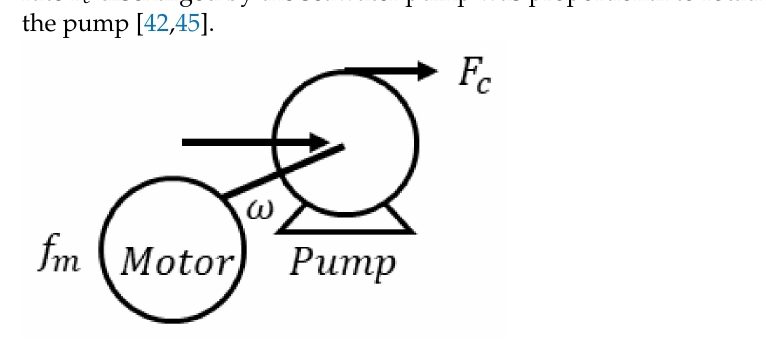
Figure 5. Motor and seawater